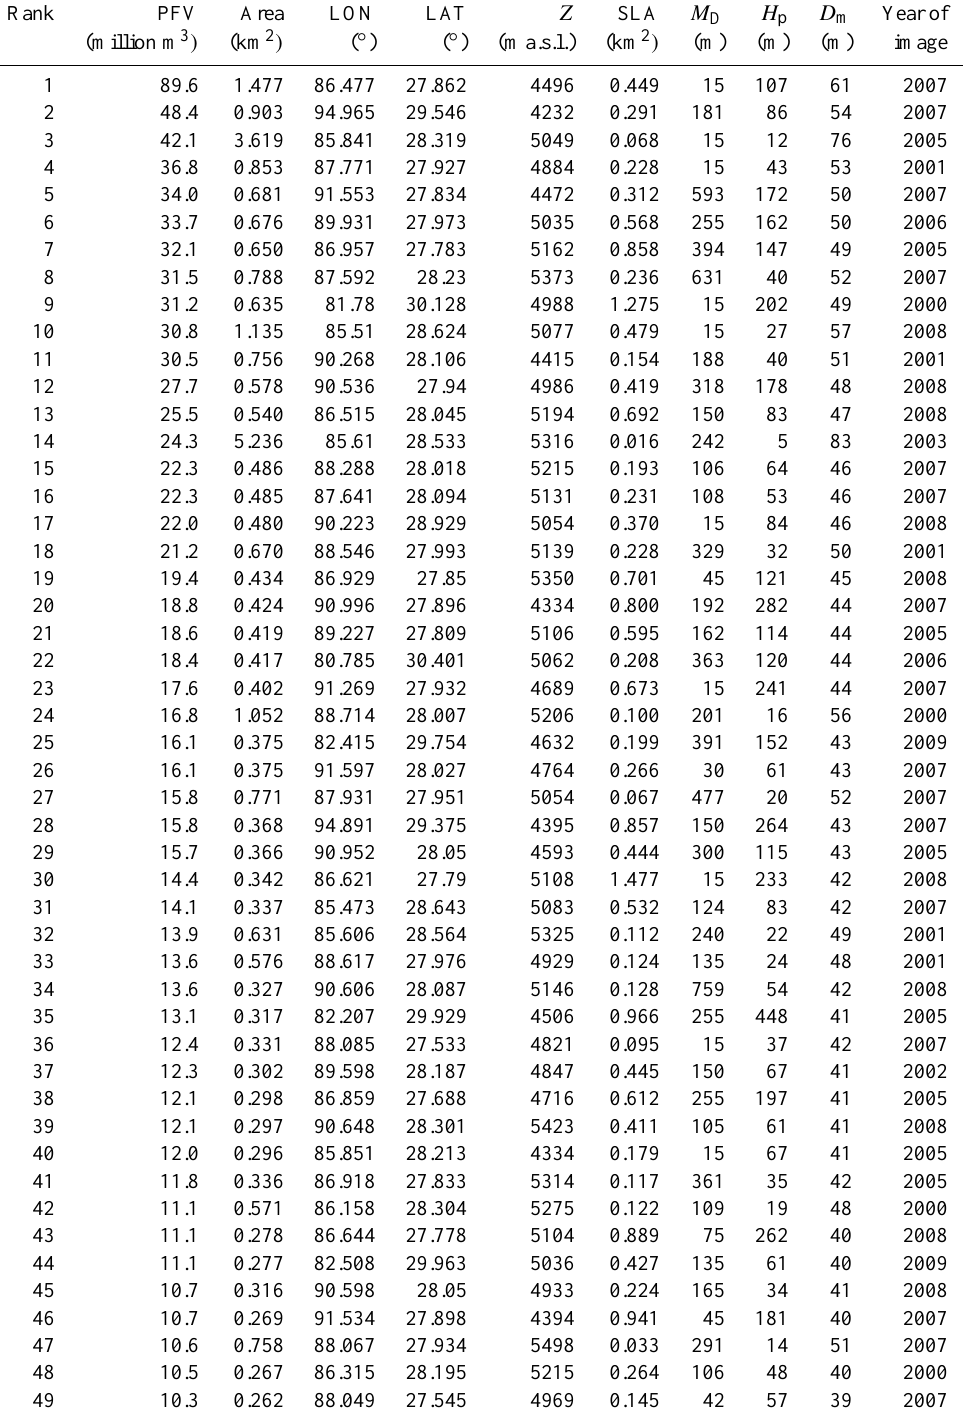
Table 3. Glacial lakes with high potential flood volume. Abbreviations are shown in the footnote of Table